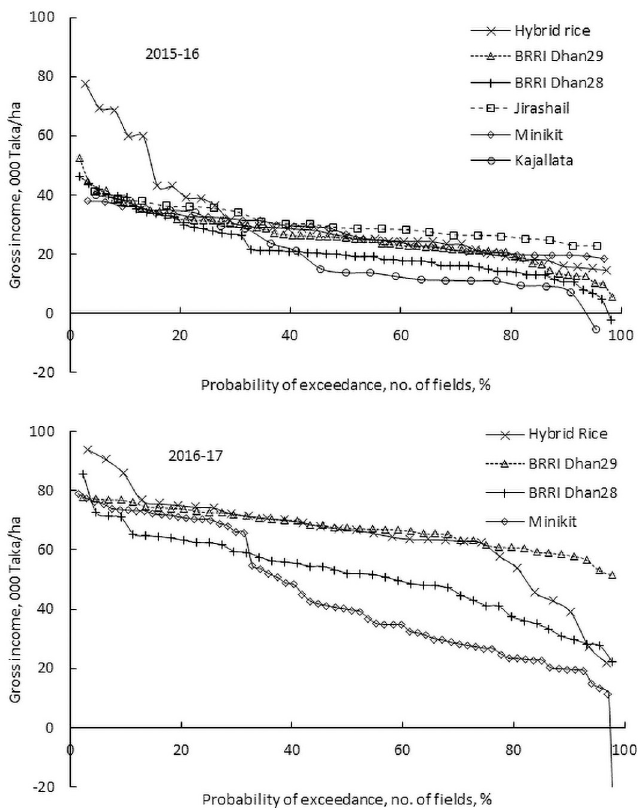
Fig 7. Probability of gross income of different Boro rice varieties cultivated at different sites in 2015–16 and 2016–17.